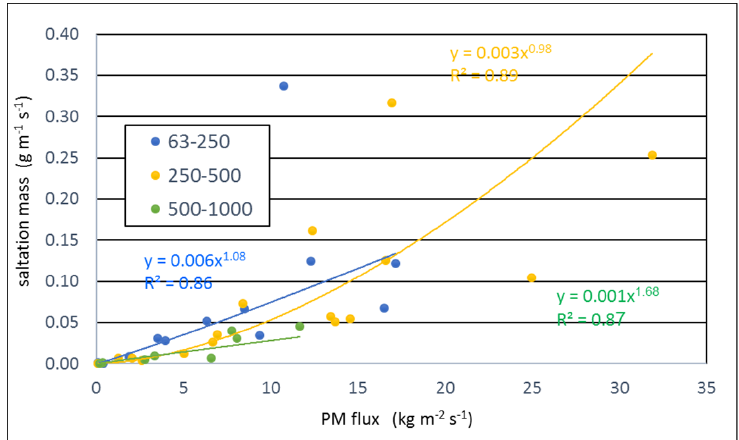
Figure 5. Nonlinear correlation between PM10 flux and saltation flux for the different soil samples. Note the different value range of saltation and PM fluxes between the soil samples.